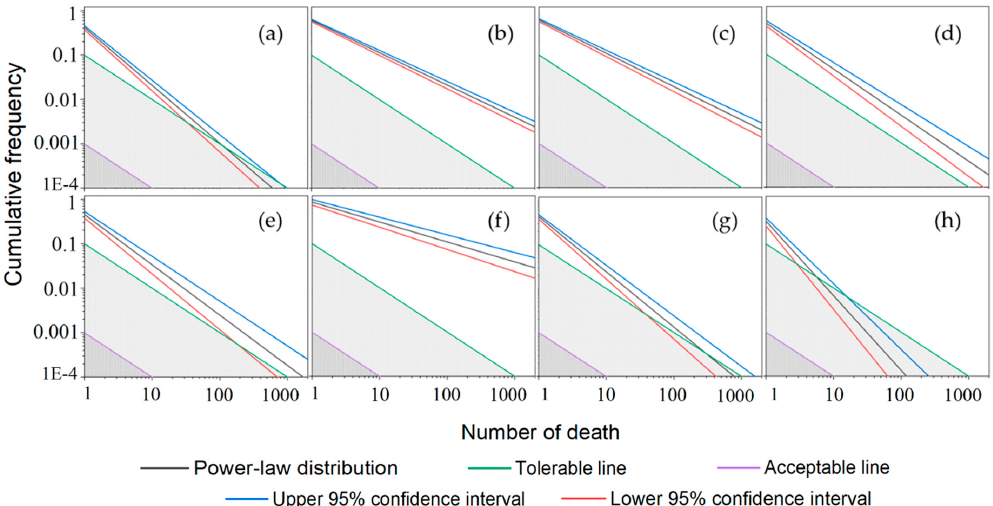
Figure 14. The F-N curves under uncertainty for different data sets, which were ( a ) 371 HTAs from 2004–2018 in China; ( b ) 1217 HTAs on road in 95 countries; ( c ) 715 HTAs on the railway in 95